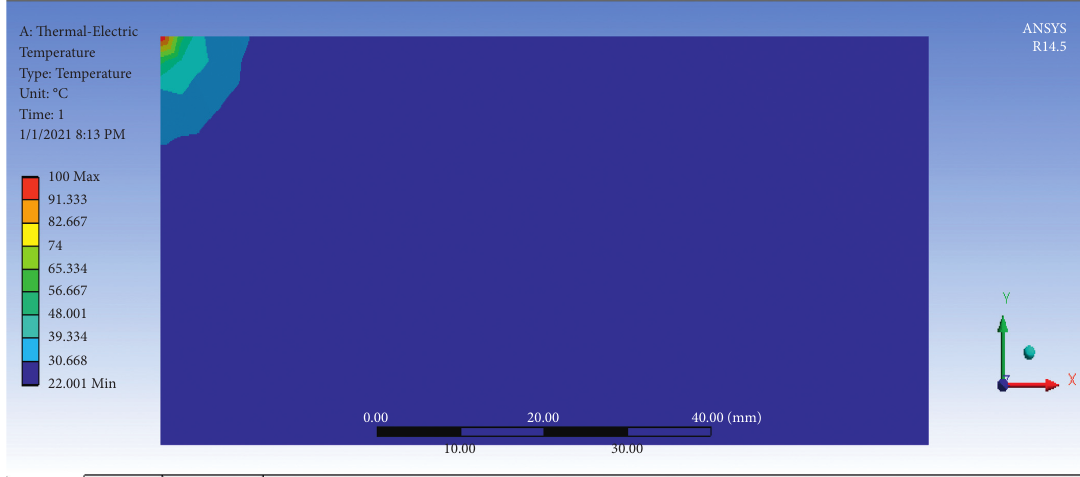
Figure 3: Temperature distribution obtained for a current intensity value of 14A and pulse duration 750 μ s. Total Heat Flux